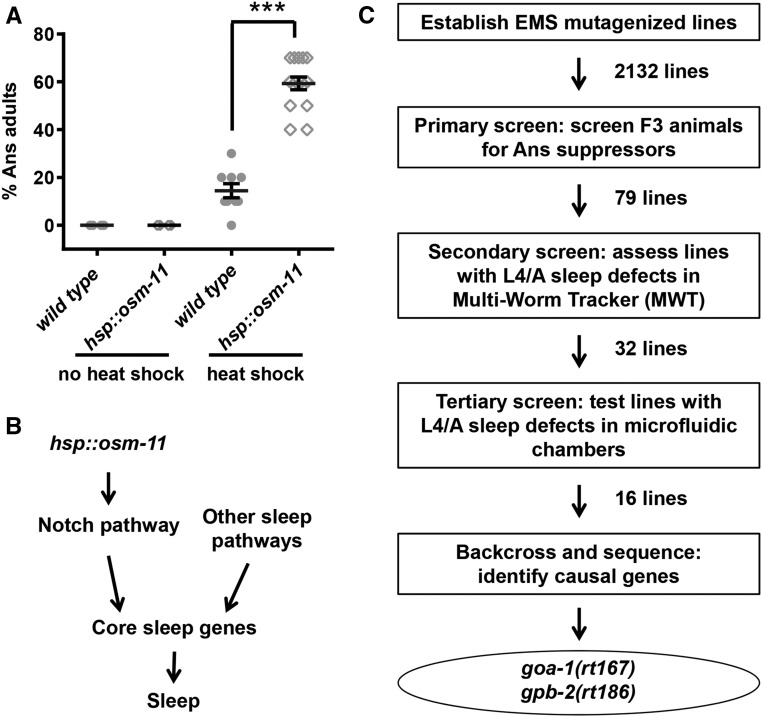
Screening rationale and strategy. (A) Heat shock-induced OSM-11 overexpression drives anachronistic sleep (Ans) at all stages, included in adult animals shown here. Each data point represents % Ans animals for an individual plate of animals. Trials were run independently on at least three different days for each genotype/treatment. *** P < 0.001. (B) Genetic pathways promoting sleep. OSM-11 expression activates Notch pathway signaling and, consequently, activates downstream core sleep pathways (e.g., egl-4 PKG) to promote both anachronistic sleep in adult animals and endogenous, developmentally timed L4/A sleep. Other sleep pathways (e.g., lin-42) likely act independently to activate core sleep pathways and promote sleep. (C) Flow chart of the screen and results. Two thousand one hundred and thirty-two F2 lines were established and the F3 progeny were screened for suppression of the Ans phenotype. Seventy-nine independent Ans suppressor lines were retained and tested for defects in endogenous L4/A lethargus sleep in population-based assays using a Multi-Worm Tracker system. Detailed analysis of L4/A lethargus sleep for 32 lines was carried out in microfluidic chambers and 16 lines showed L4/A sleep defects. Seven lines were backcrossed and their genomic DNA was sequenced to find causal alleles. Genes whose loss of function results in sleep defects were identified for two mutant lines and were confirmed using previously described alleles.